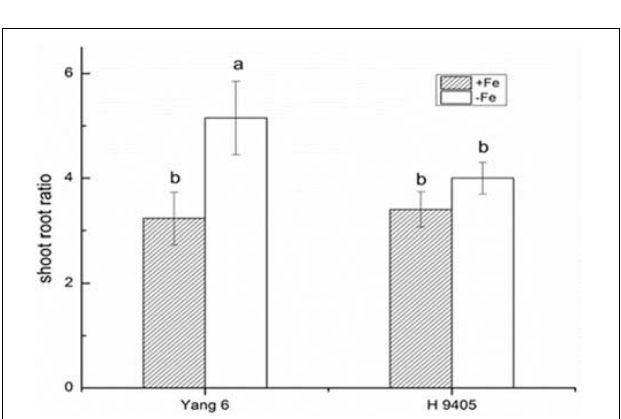
FIGURE 5 | Effects of iron deficiency on shoot-root ratio of Yang 6 and H 9405. Data are presented as means ± SE of three biological replicates. Significant differences among treatments are indicated by different letters as determined by Duncan’s test ( P < 0.05).